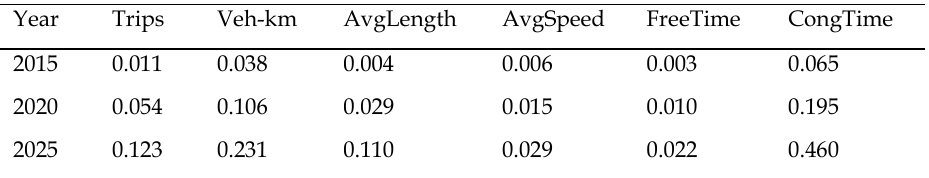
Coefficient of variation by year and model